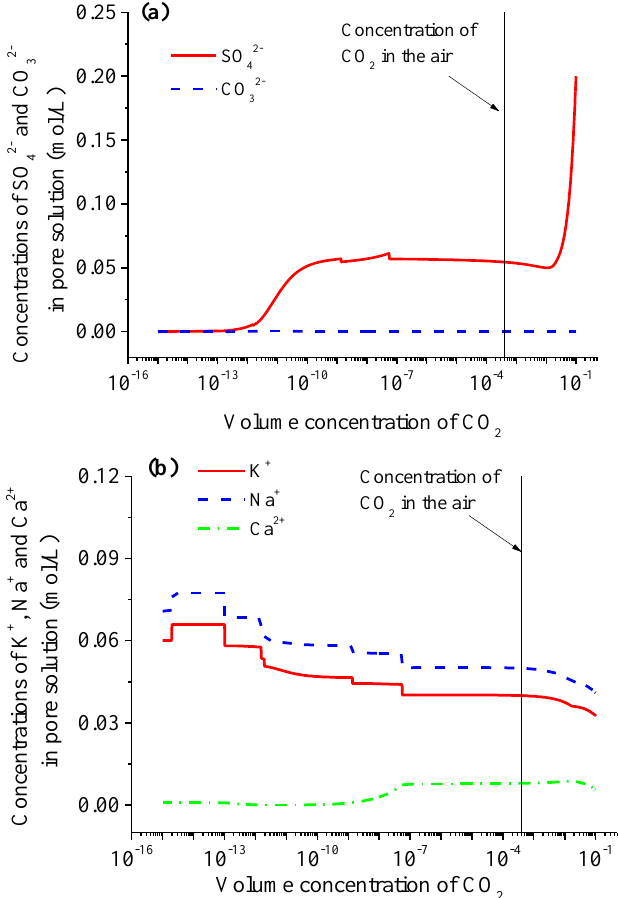
Figure 4. Ionic concentrations in the pore solution of the completely carbonated mortar as a function of the CO 2 concentrations: ( a ) and ( b ) represent the concentrations of anions and cations, respec- tively.